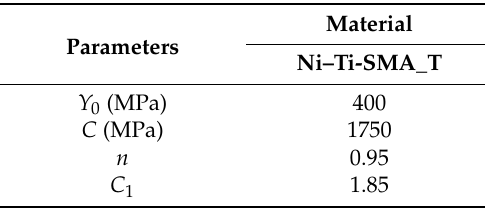
Table 5. Values of Y 0 , C , n , and C 1 for the Ni–Ti shape-memory-alloy theoretical material used in the comparison with literature experimental results.